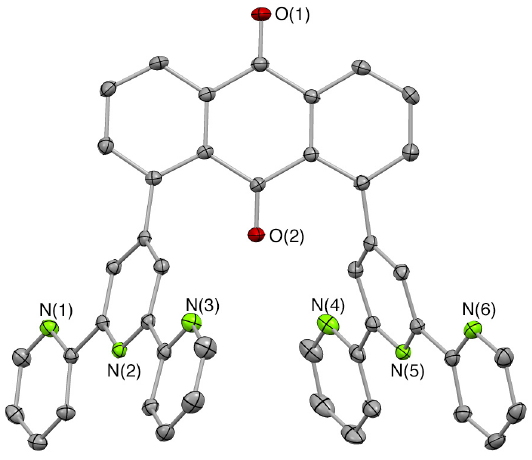
Figure 1. Crystal structure of btpyaq (50% probability thermal ellipsoids). Hydrogen atoms are omitted for clarity.